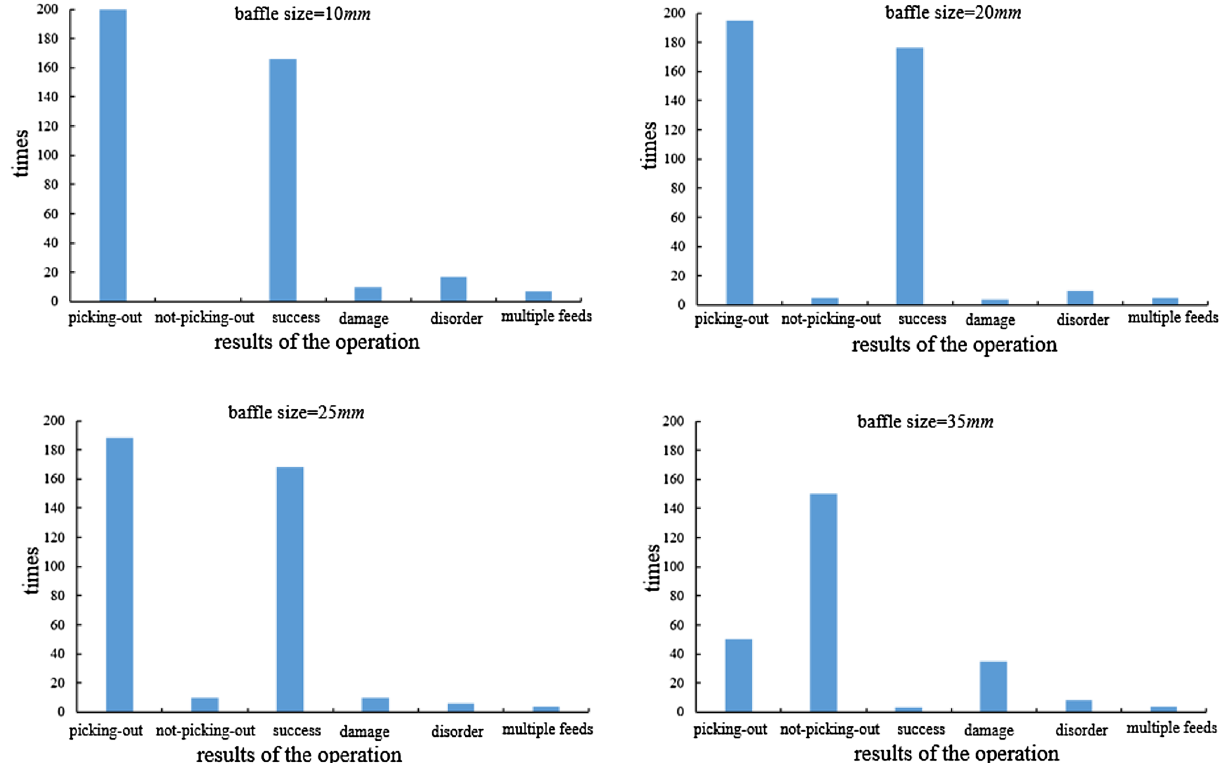
Fig. 12 Results of the operation when the x -dimension baffle heights